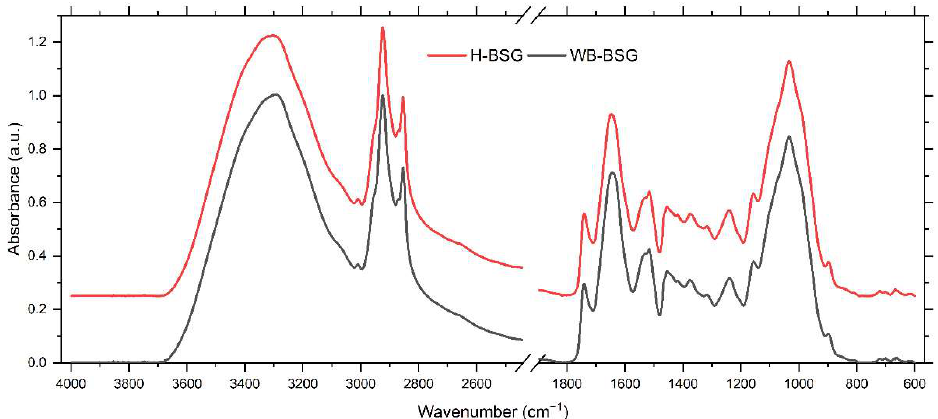
Figure 1. ATR-FTIR spectra of H-BSG (red) and WB-BSG (grey). Spectra were normalized to ν as CH 2 (2924 cm −1 ) and isolated by an offset. CH 2 symmetric (2854 cm −1 ) and asymmetric (2924 cm −1 ) stretching vibration, overlapping stretching vibrations of primary alcohols, primary amines and Si-OH (3305 cm −1 ), carboxylic bands ν C=O (1741 cm −1 ) and ν COO- (1377 cm −1 ), amide I and II (1645 cm −1 and 1517 cm −1 , respectively) phenolic C-C-O stretching vibrations (1239 cm −1 ), hydroxylic functionalities ν C-O (1156 cm −1 ) and stretching vibrations C-O-C (1035 cm −1 ).